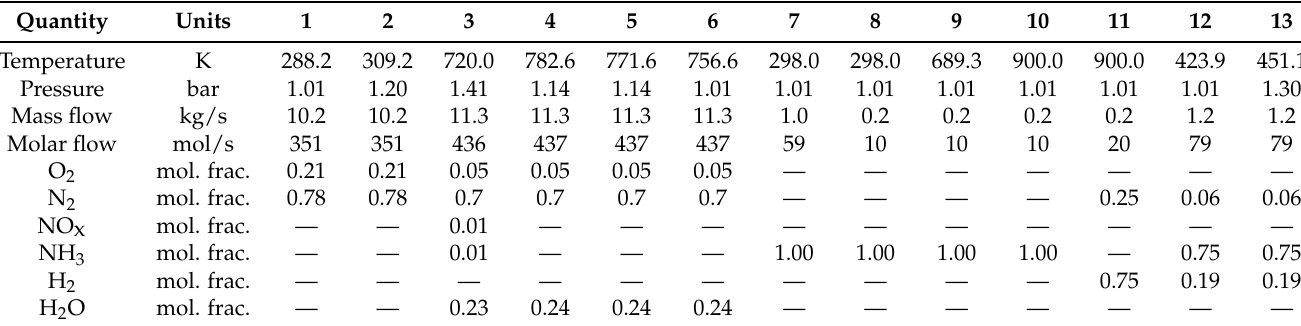
Table 11. The state points corresponding to the process flow diagram given by Figure 13 for an ICE 6.48 MW regional ferry at MCR.